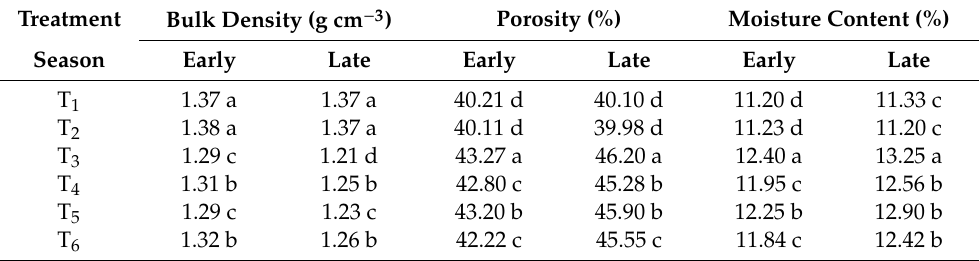
Table 4. Changes in soil physical properties under combined organic and inorganic fertilizers. Treatment Bulk Density (g cm − 3 ) Porosity (%) Moisture Content (%)